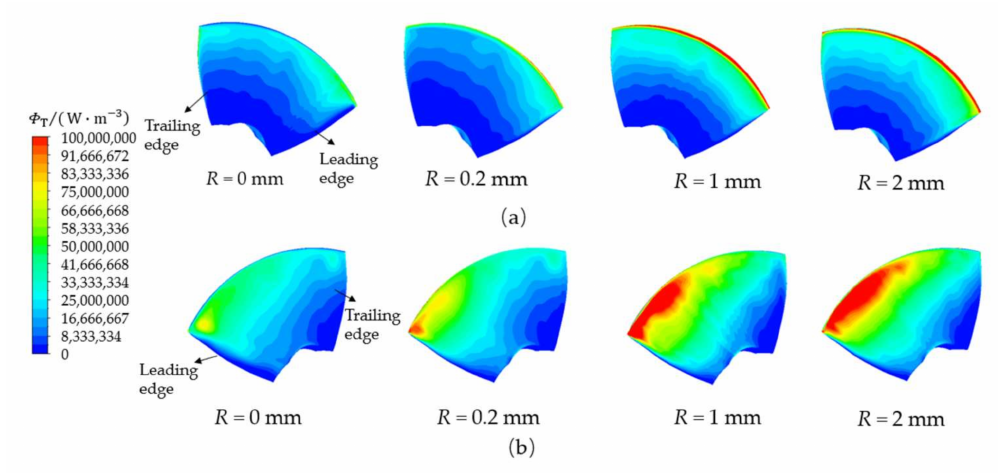
Figure 12. Dissipation rate distribution on blade surface under pump condition. ( a ) Pressure side. ( b ) Suction side.